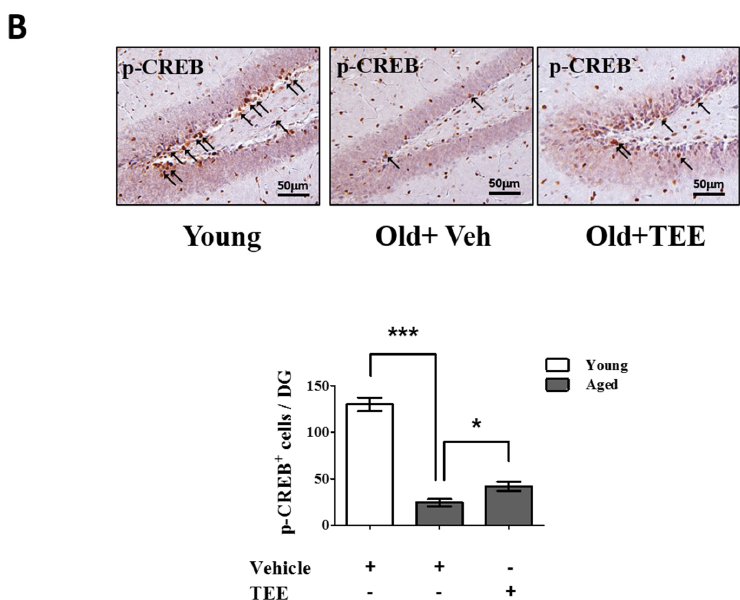
Figure 5. Oral administration of TEE activated extracellular ‐ signal ‐ regulated kinase (ERK) and cAMP response element binding (CREB) signaling pathways in aged hippocampus. ( A ) The changes in the phosphorylated form of ERK in the mice hippocampus were analyzed via Western blotting using phospho ‐ specific ERK. The bands shown are four representatives from each group. The relative protein expressions of phospho ‐ ERK were analyzed using the ImageJ software. The intensity of the bands was normalized to the total ERK; ( B ) To analyze the CREB activation in DG, phospho ‐ CREB immunostaining was performed. Representative photographs of phospho ‐ CREB + cells in the hippocampal DG are shown. The arrows indicate phospho ‐ CREB + cells. The number of phospho ‐ CREB + cells in the DG was quantified in the graph in the lower panel. Each bar represents the mean ± SEM of each group ( n = 9). The asterisks denote a significant difference (*, p < 0.05; **, p < 0.01; ***, p < 0.001).